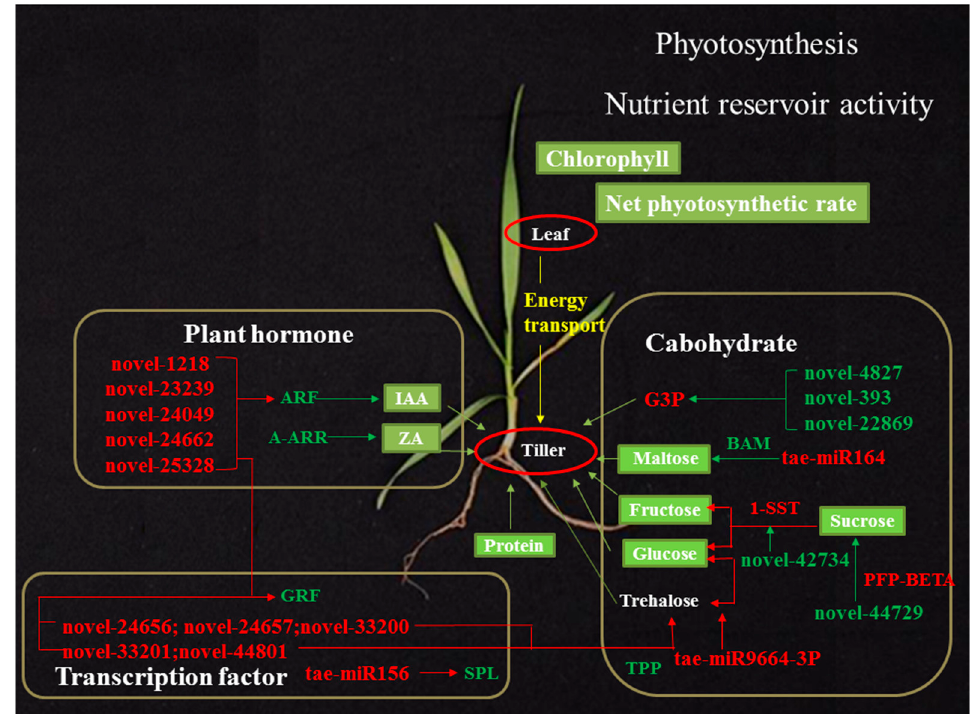
Figure 12. A molecular regulatory hypothesis of the dmc . Red: up-regulated; green: down-regulated compared to WT. Lower photosynthesis from the leaves produces fewer energy substances for transport to tiller nodes (Figure 5). Differentially expressed miRNAs regulated their target genes in the carbohydrate metabolism pathway and resulted in lower sugar content in tiller nodes (Figures 6 and 7). Differentially expressed miRNAs also regulate transcription factor genes such as SPL , GRF , and plant hormone metabolism genes, such as ARF and A-ARR (Figure 8). Transcription factors, in turn, regulate other metabolisms such as carbohydrate and plant hormone metabolism pathways. In the end, the key substances that guarantee normal wheat tillering are in significant deficit, such as plant hormones IAA and ZA, soluble sugars, and proteins. These are the major factors restraining tillering in dmc .